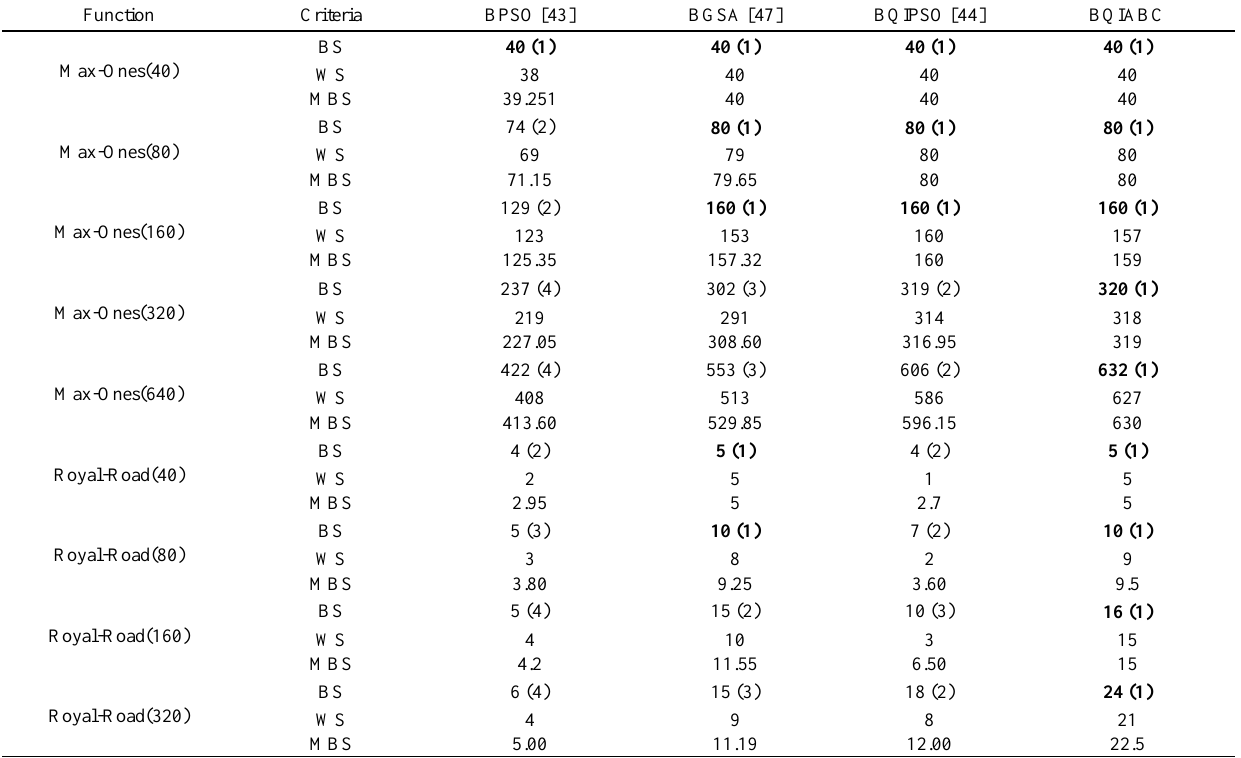
Table 5. Comparison between BQIABC and some binary algorithms using Max-Ones and Royal-Road with different sizes.